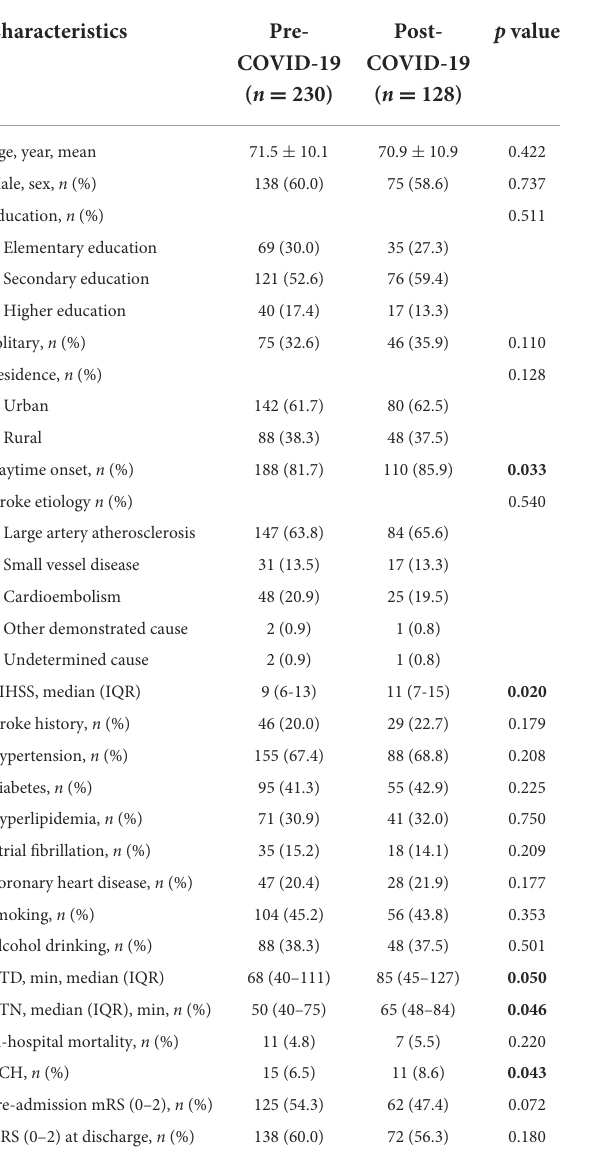
TABLE 2 Characteristics of acute ischemic stroke patients with mechanical thrombectomy treatment before and after the COVID-19